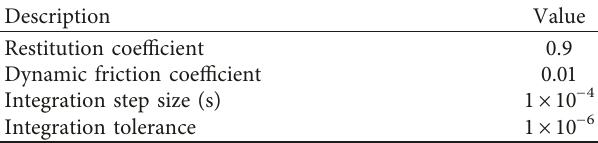
Table 5: Simulation parameters of the rock-breaker